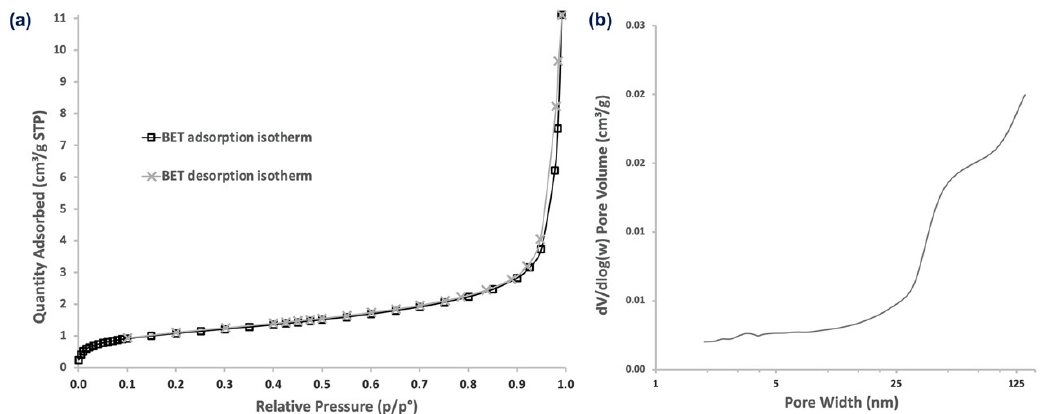
Figure 12. N 2 adsorption/desorption isotherms ( a ) and pore size distribution ( b ) of α -CD-NS. Linear response using the GC-FID method described above was obtained, and the amount of ethylene inside the vials was successfully quantified by integrating the area under the ethylene peak. To evaluate the ethylene removal capacity, the ethylene ratio between each replicate and the control for each time point was calculated. Figure 13 shows the ethylene removal behavior of the different absorbent com- pounds tested. In the case of zeolites, the concentration inside the vial tended to increase throughout the assay, and, as a result, negative ethylene removal percentages ranging